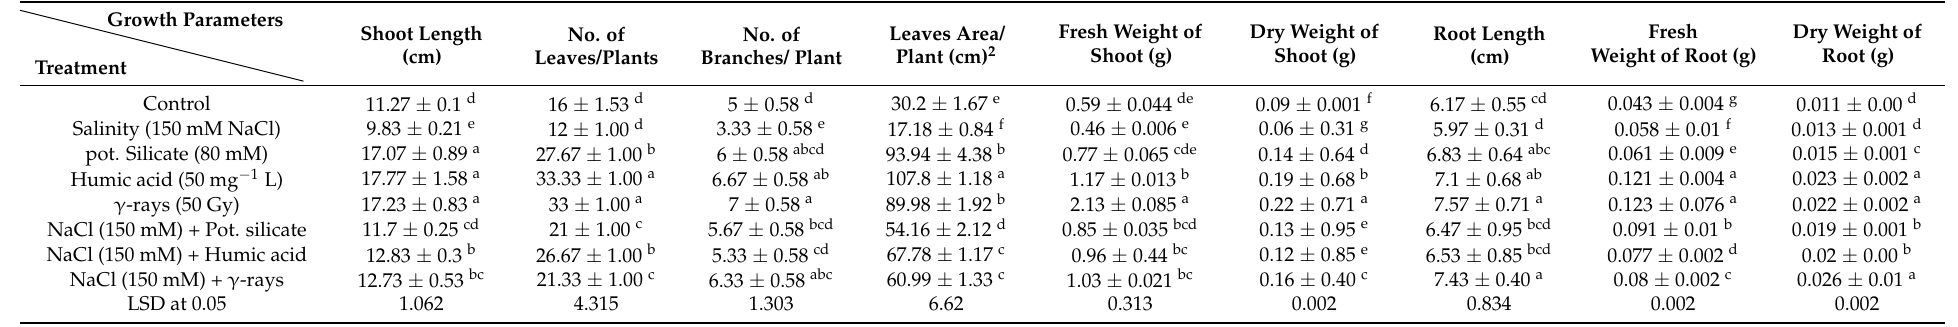
Table 2. Influence of biostimulants’ pretreatments on vegetative growth parameters of coriander plants under salinity stress at the vegetative stage. Control and salinized stressed coriander samples were subjected to 80 mM pot. silicate, 50 mg L − 1 HA or soaked in water after exposure by 50 Gy γ -rays. Based on Duncan’s multiple range test, the different alphabetical letters express significant variation (defined as p < 0.05).